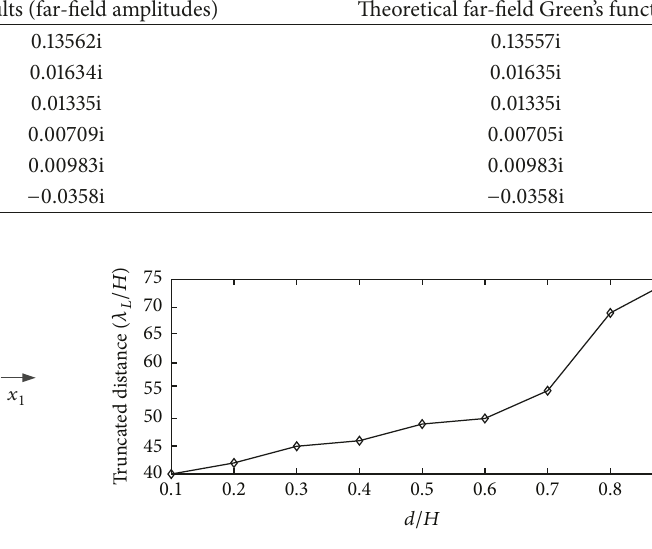
Figure 4: Schematic diagram for the unit line source problem. Figure 5: Proper truncation distance with various 𝑑 for the unit line source problem.